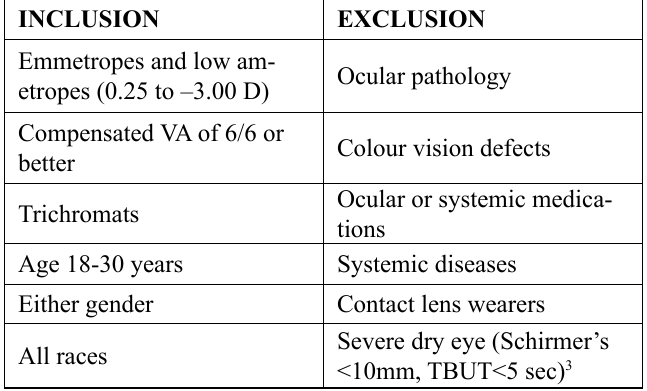
Table 1: Inclusion and exclusion